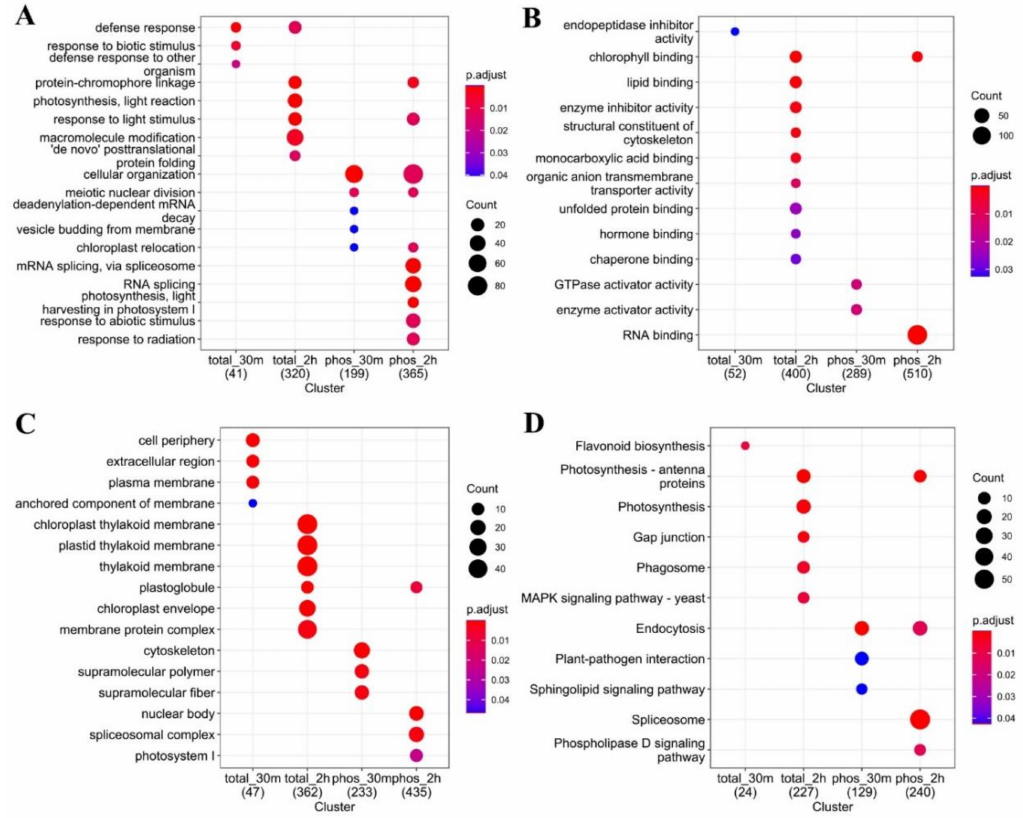
Figure 6. Functional enrichment of cold-responsive proteins and phosphoproteins using GO terms of biological process ( A ), molecular function ( B ), and cellular component ( C ), or using KEGG pathway terms ( D